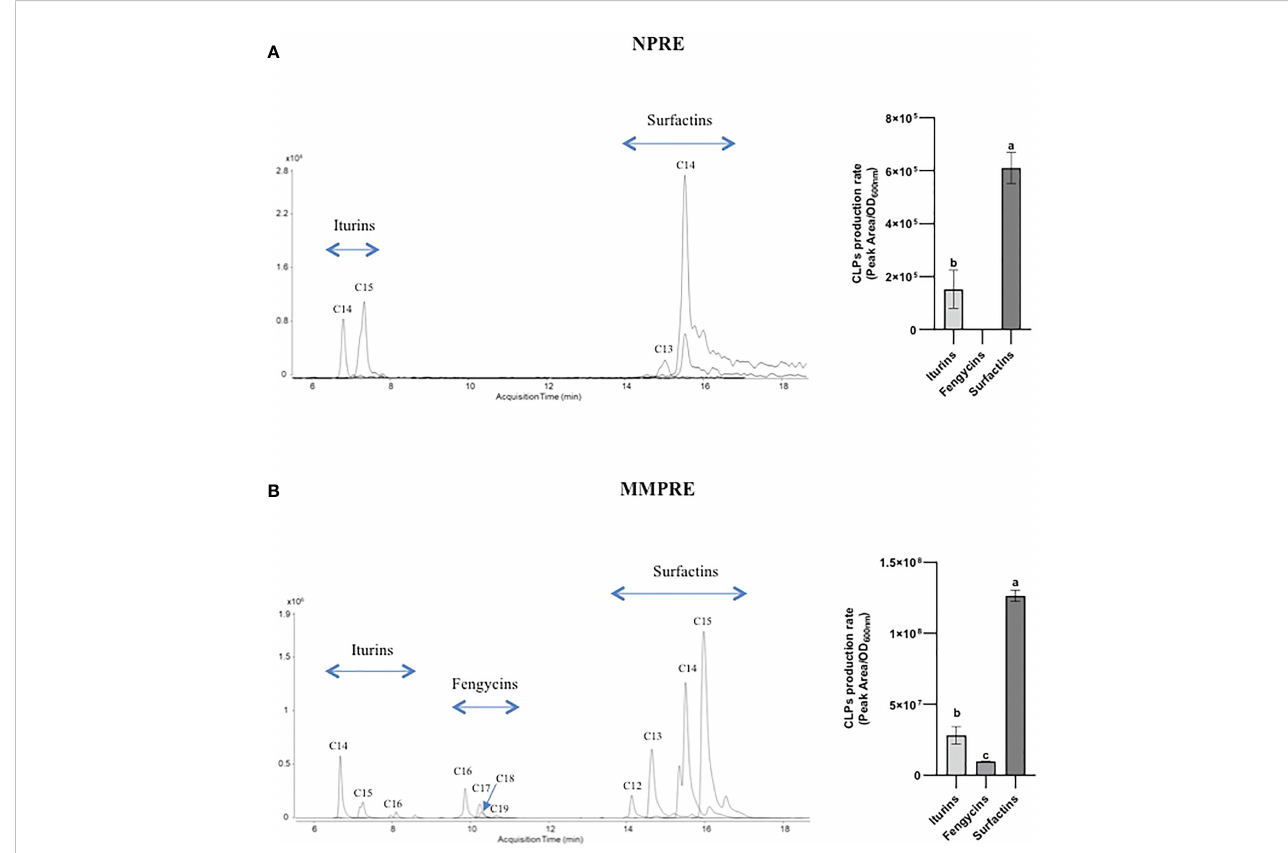
FIGURE 2 LC-MS extracted ion chromatograms (EICs) of CLPs families produced by B velezensis GA1 in liquid NPRE (A) and MMPRE (B) culture. The different peaks correspond to homologues of the considered family with different fatty acid chain lengths as indicated. For each medium, the relative proportions of the various CLPs have been calculated based on peak area/OD and are also represented in graphs on the right. Means ± SD from two biological replicates (with similar OD) of one experiment are shown. Treatments with different letters are signi fi cantly different (p <